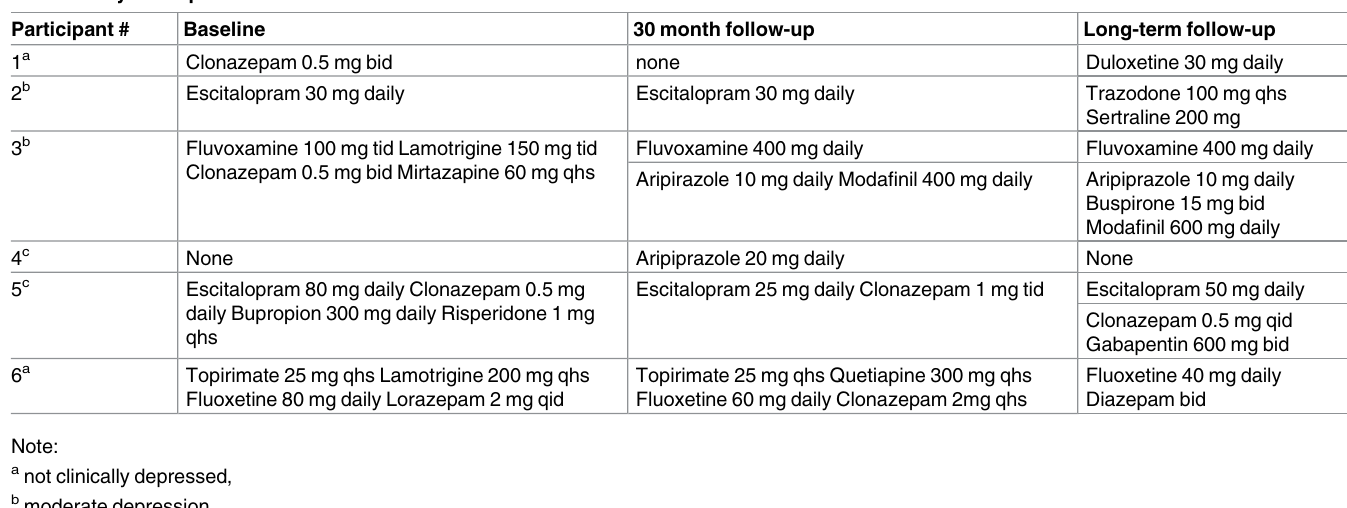
c severe depression. Table shows the medication prescribed at baseline, 30-month follow-up, and long-term follow-up for the six patients with chronic OCD who received